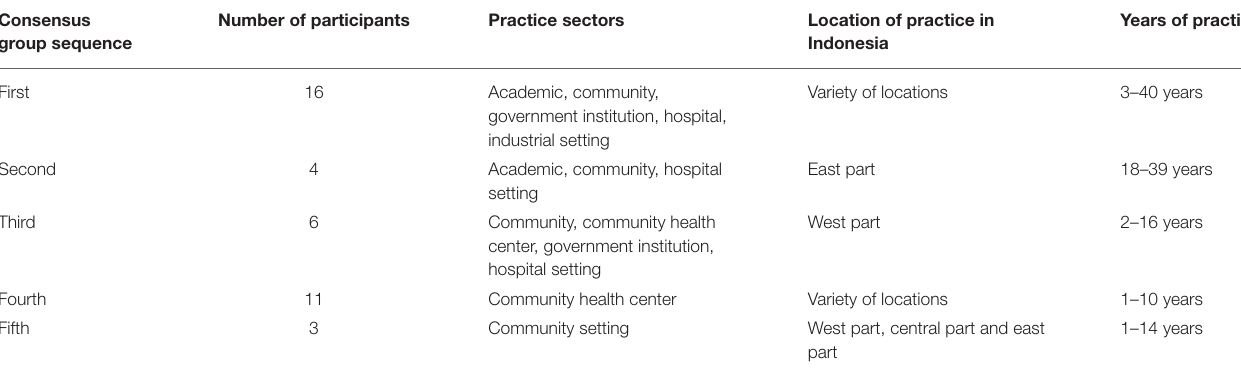
TABLE 1 | The demographics of participants in the consensus development